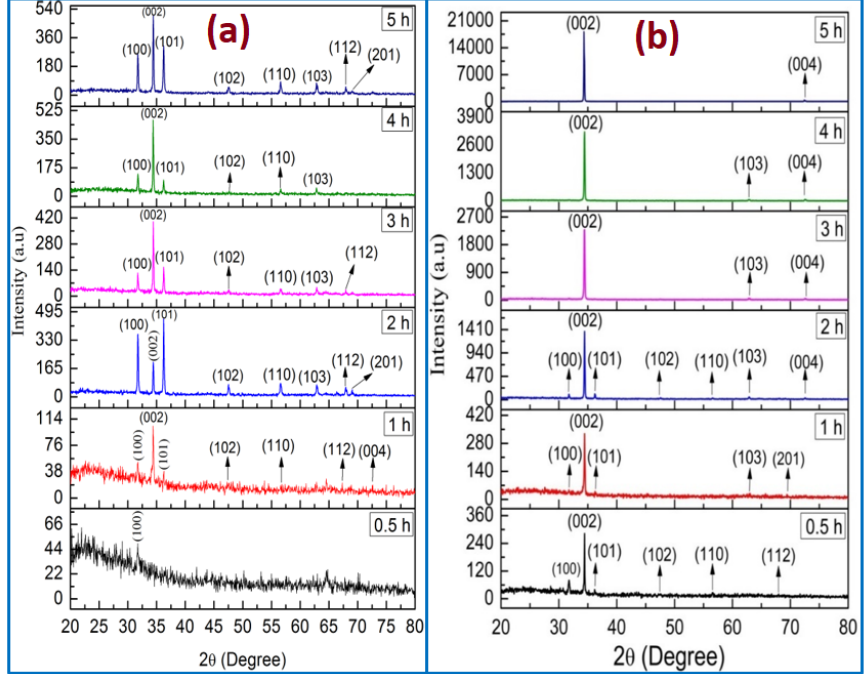
Figure 8. X-ray diffraction patterns of ZnO nanorods grown for different growth durations: ( a ) no air bubbles and ( b ) air bubbles.